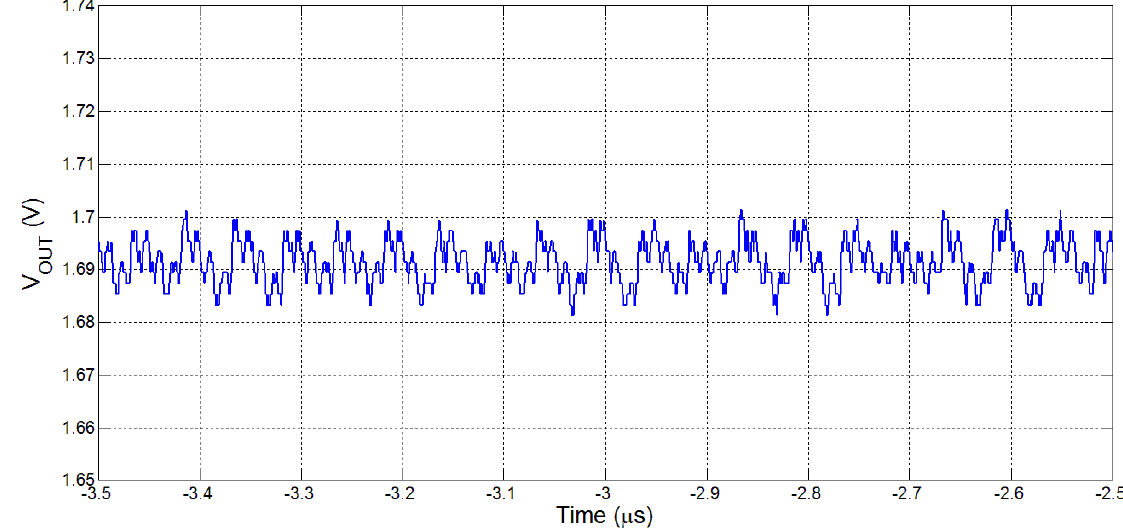
Figure 4. Measured V regulation at 1.70 V for a load current of 300 µ OUT